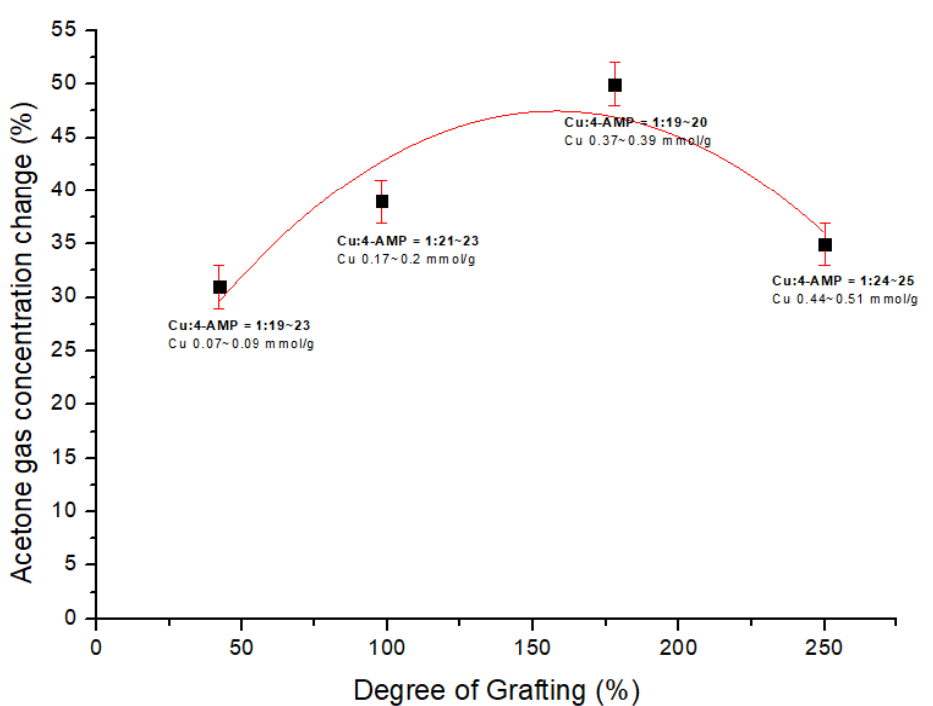
Figure 11. Dependence of acetone gas adsorption on the degree of grafting (about 50 ppm).